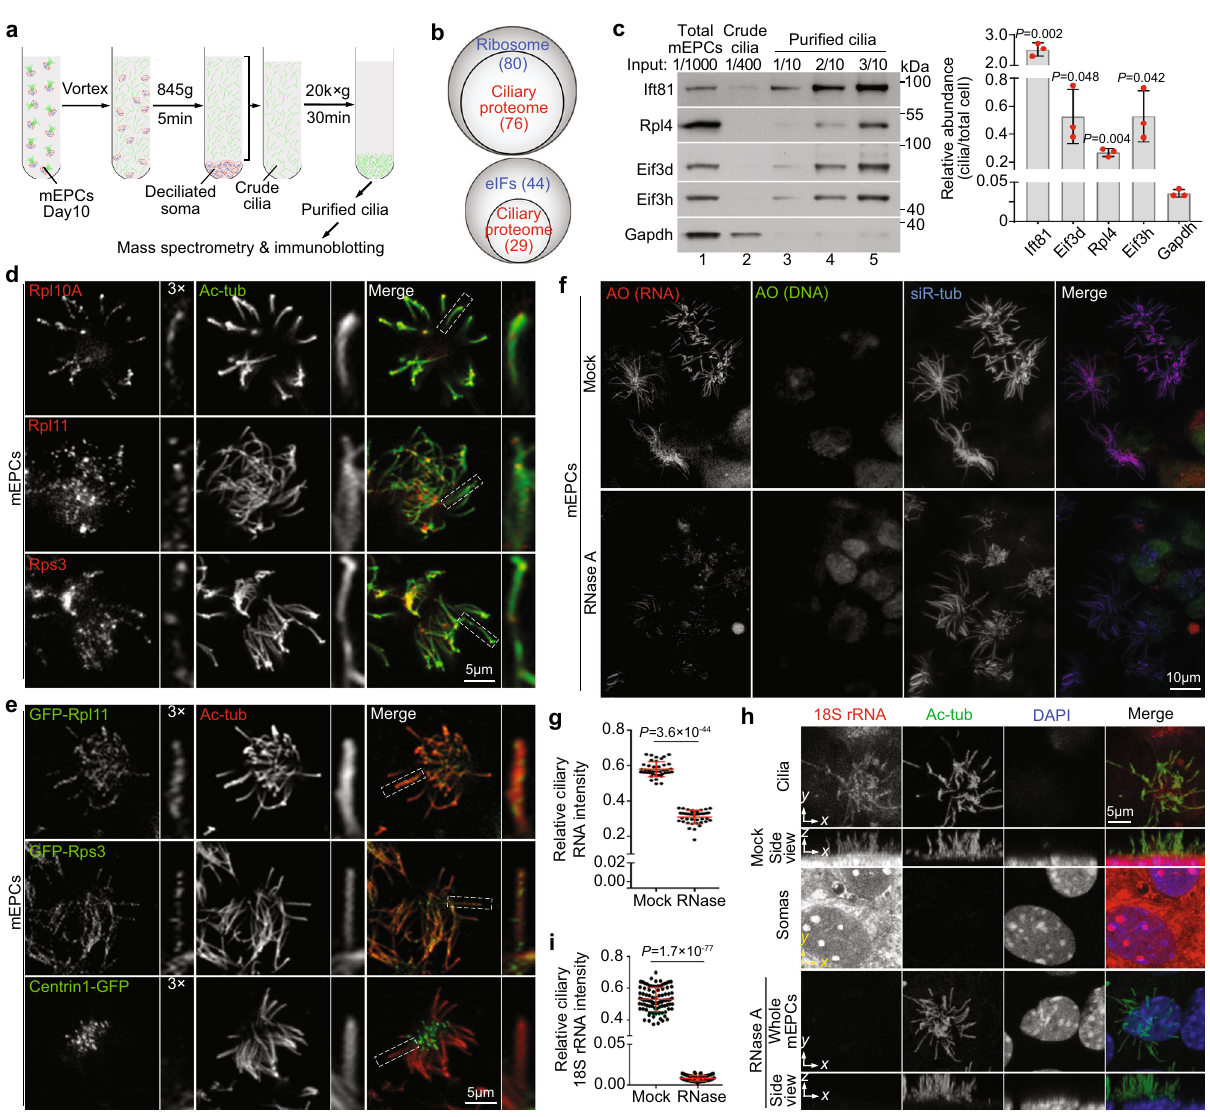
Fig. 1 Ependymal multicilia contain ribosomal components and RNA. Pooled results are presented as mean ± s.d. Two-tailed student ’ s t -test. a Experimental scheme for cilia puri fi cation. b Venn diagrams showing that ciliary proteome contained most ribosomal and eIF components. Proteomics of puri fi ed multicilia identi fi ed 76 out of 80 known ribosomal proteins and 29 out of 44 eIF components as compared with AmiGo 2 open-source. c Rpl4, Eif3d, and Eif3h were enriched in puri fi ed multicilia. IFT81 and Gapdh served as ciliary and cytosolic markers, respectively. Band intensities of lane 4 relative to lane 1 were measured ( n = 3 biologically independent experiments). Refer to Supplementary Fig. 1a for an additional set of results. d Endogenous Rpl10A, Rpl11, and Rps3 localized in multicilia of cultured mEPCs. Typical cilia were magni fi ed to show details. Acetylated tubulin (Ac-tub) labeled ciliary axonemes. e GFP-tagged Rpl11 and Rps3 displayed ciliary localization. mEPCs were infected with lentivirus at 1 day before serum starvation (day − 1) to express GFP- Rpl11, -Rps3, or Centrin1. f, g Multicilia were abundant in RNA. Cilia are marked with siR-tub and the cells were stained with acridine orange (AO) after mock or RNase A treatment. Representative z-projected images from cilia-containing z-stacks are shown ( f ). Refer to Supplementary Figure 1b for z-projected images for cell bodies of the same samples. Ciliary AO fl uorescent intensity was normalized to that of siR-tub ( g ). 40 multiciliated mEPCs were quanti fi ed in each condition. h, i Ependymal cilia contained 18 S rRNA. mEPCs fi xed at day 10 were treated with or without RNase A, followed by smFISH to detect 18 S rRNA. Ac-tub and DAPI, respectively, labeled cilia and nuclei. For the representative mock-treated sample, z-projected images from z-stacks above and below the dashed yellow line, respectively, are presented to show fl uorescent signals in cilia and soma ( h ). For the representative RNase-treated sample, the z-projected images were from the entire z-stacks ( h ). Ciliary FISH fl uorescent intensity was normalized to that of Ac-tub ( n = 3 independent experiments). 30 multiciliated mEPCs were measured in each experiment and